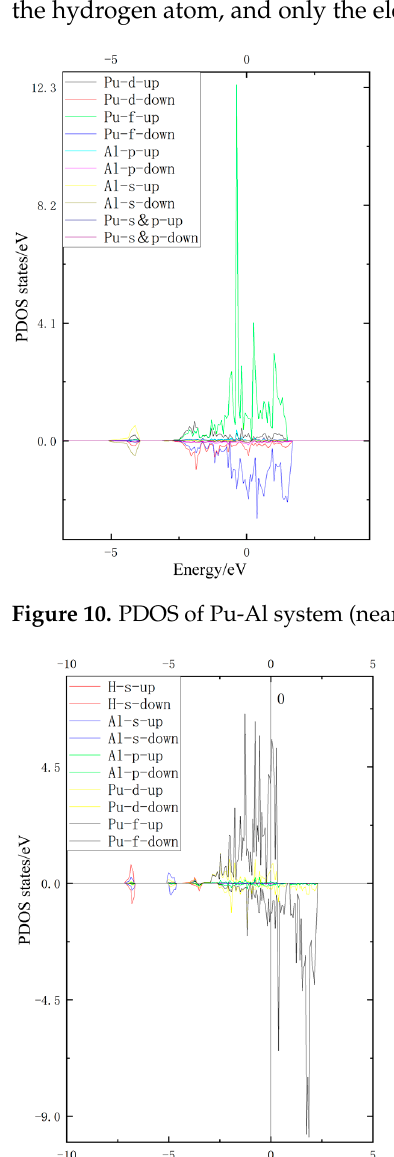
Figure 11. PDOS of Pu-Al system adsorbed with H (near the Fermi level).